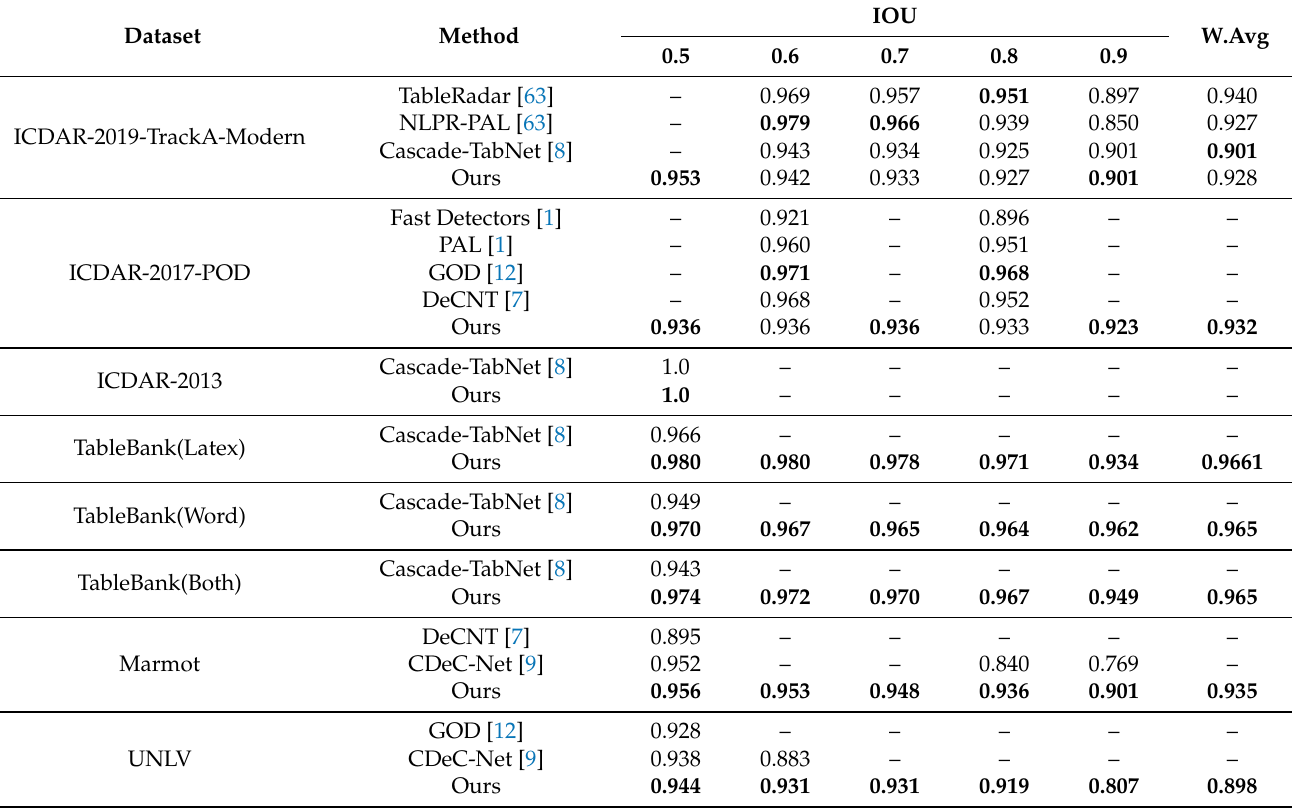
Table 6. Comparison of HybridTabNet on f1-scores with previous state-of-the-art methods. Our proposed method achieved state-of-the-art performance on every dataset except ICDAR-2017-POD. W.Avg denotes the weighted-average of the respective measure on the IoU